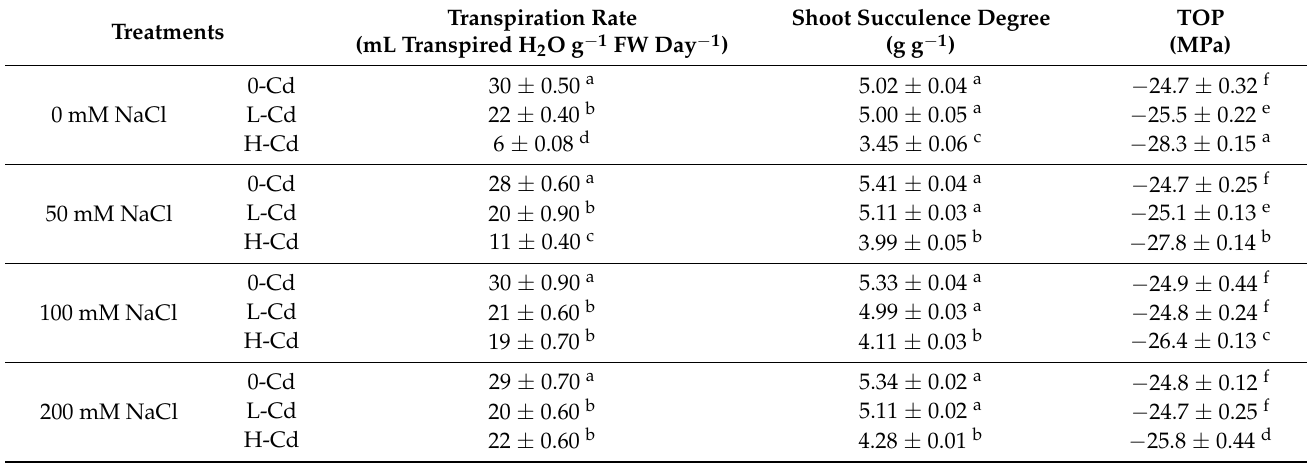
Table 1. Transpiration rate (mL transpired H 2 O g − 1 FW day − 1 ), shoot succulence degree (g g − 1 ), and total osmotic potential (TOP; MPa) in leaves of S. fruticosa exposed to nutrient solution containing 0, 25, and 50 µ g L − 1 Cd (0-Cd, L-Cd and H-Cd, respectively) without or with 50, 100, and 200 mM NaCl. Each value is the average of four replicates ± SE. Values bearing different letters are significantly different at p < 0.05 based on Tukey’s